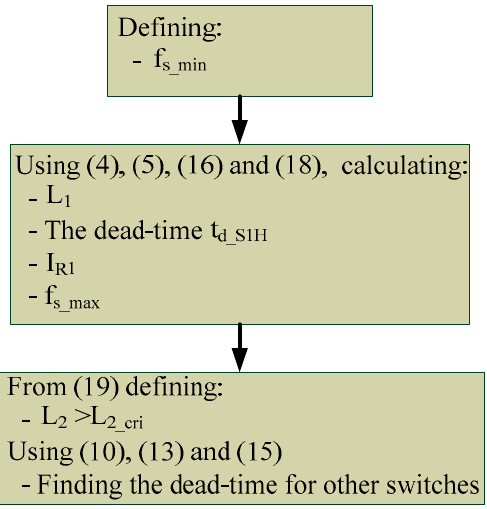
Figure 7. The steps to find L 1 , L 2 , the dead-time for all switches in the circuit, and the range of the switching frequency.